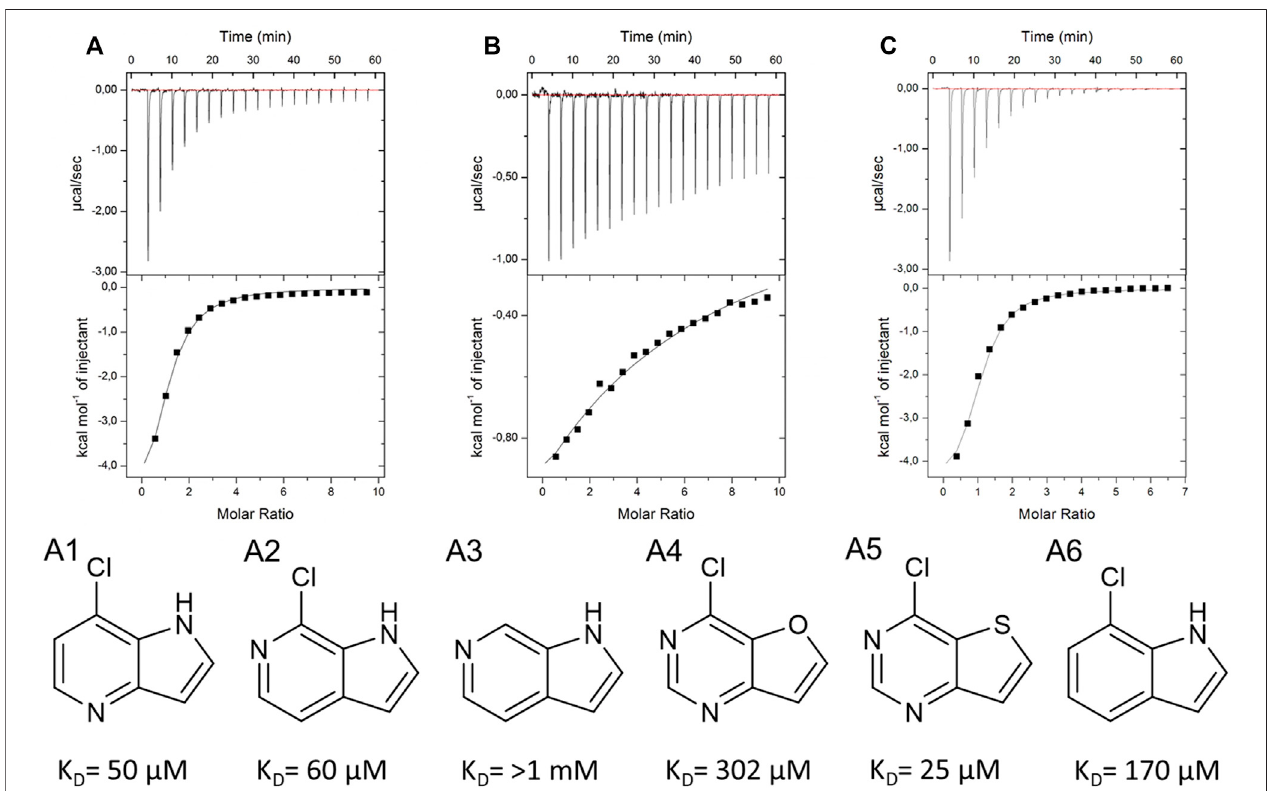
FIGURE 8 | SAR compounds for the hit fragment 9595 with AAK. ITC plots show the raw data for the compounds A1 (A) , A3 (B) , and A5 (C) .